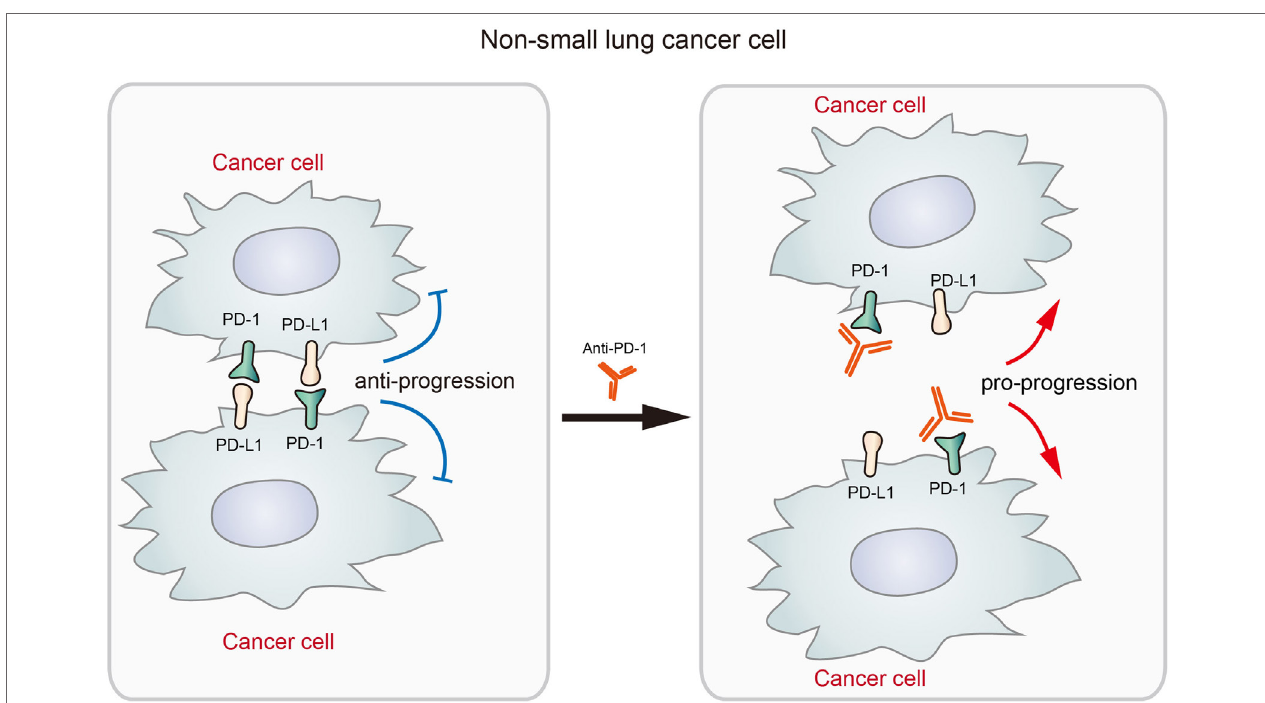
FiGURe 3 | The diagram shows that the blockade of tumor-intrinsic programmed death 1 (PD-1) promotes tumor growth in lung cancer. The interaction between tumor-intrinsic PD-1 and PD-L1 inhibits tumor progression, but the treatment by anti-PD-1 disrupts this inhibitory signaling and promotes tumor progression. This process represents an adverse effect of anti-PD-1 therapy for activating antitumor